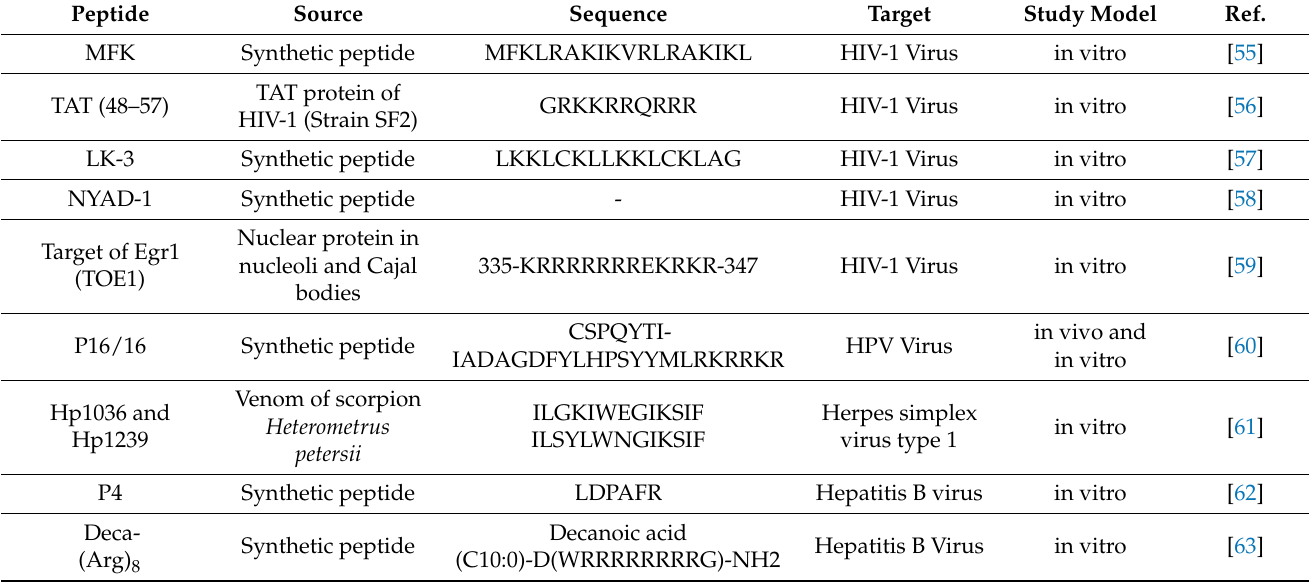
Table 2. Cell-penetrating antimicrobial peptides with antiviral